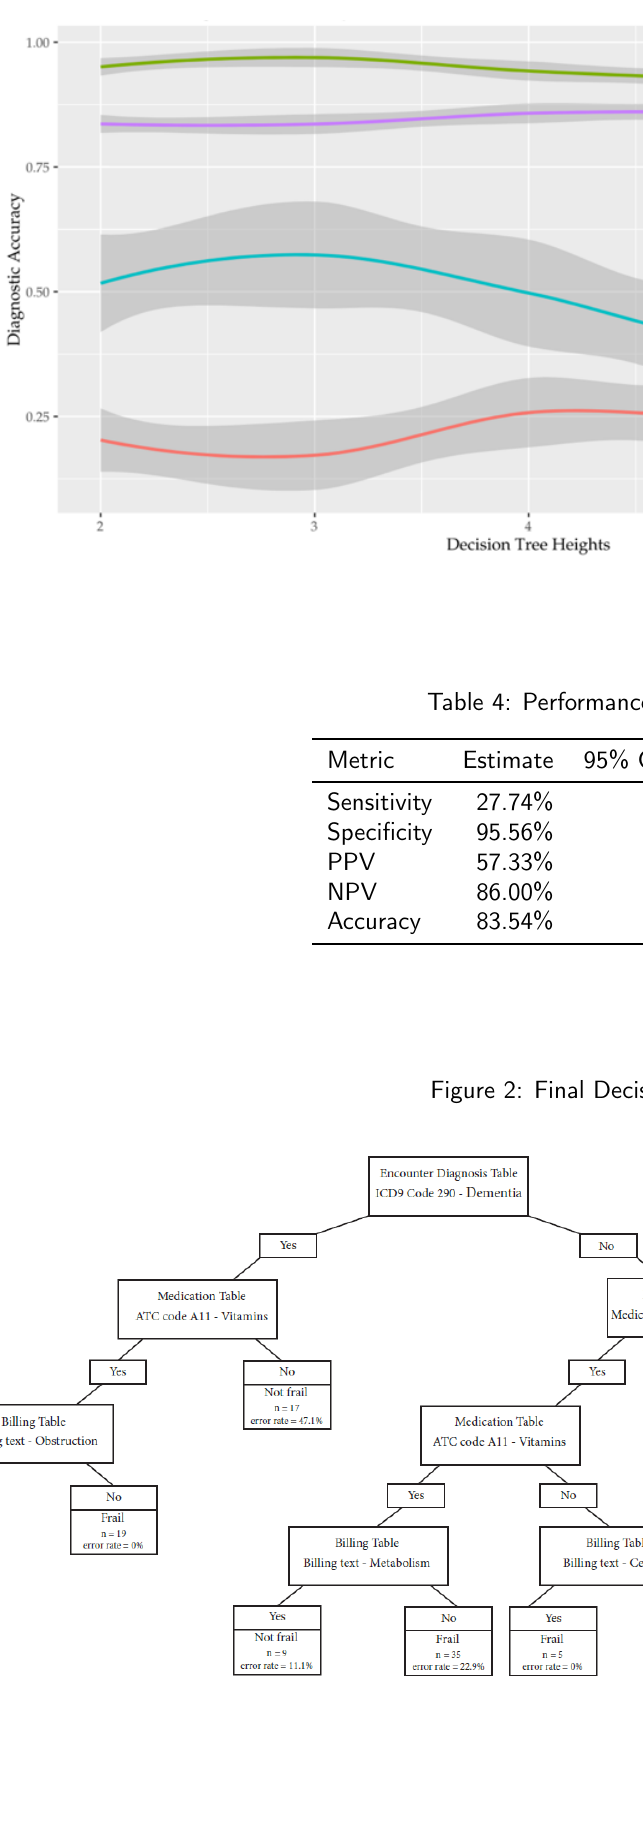
Figure 1: Visualization of Diagnostic Accuracy Using Various Decision Tree Heights